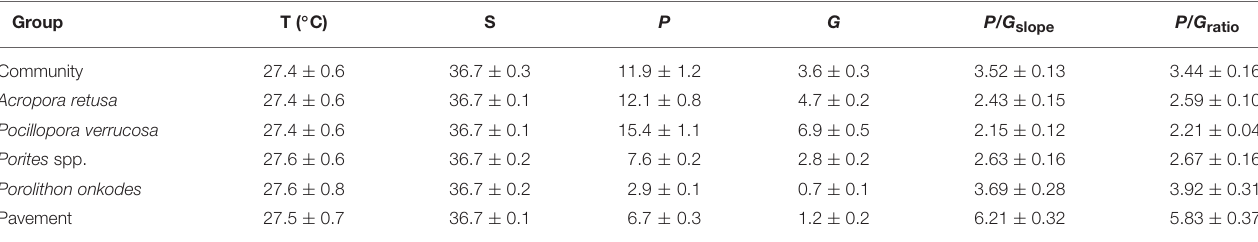
TABLE 1 | Seawater temperature [T ( ◦ C)], salinity (S), net production ( P ), and net calcification ( G ) for the experimental communities and their constituent members; values are mean ± SE. Group T ( ◦ C) S P G P/G slope P/G ratio Community